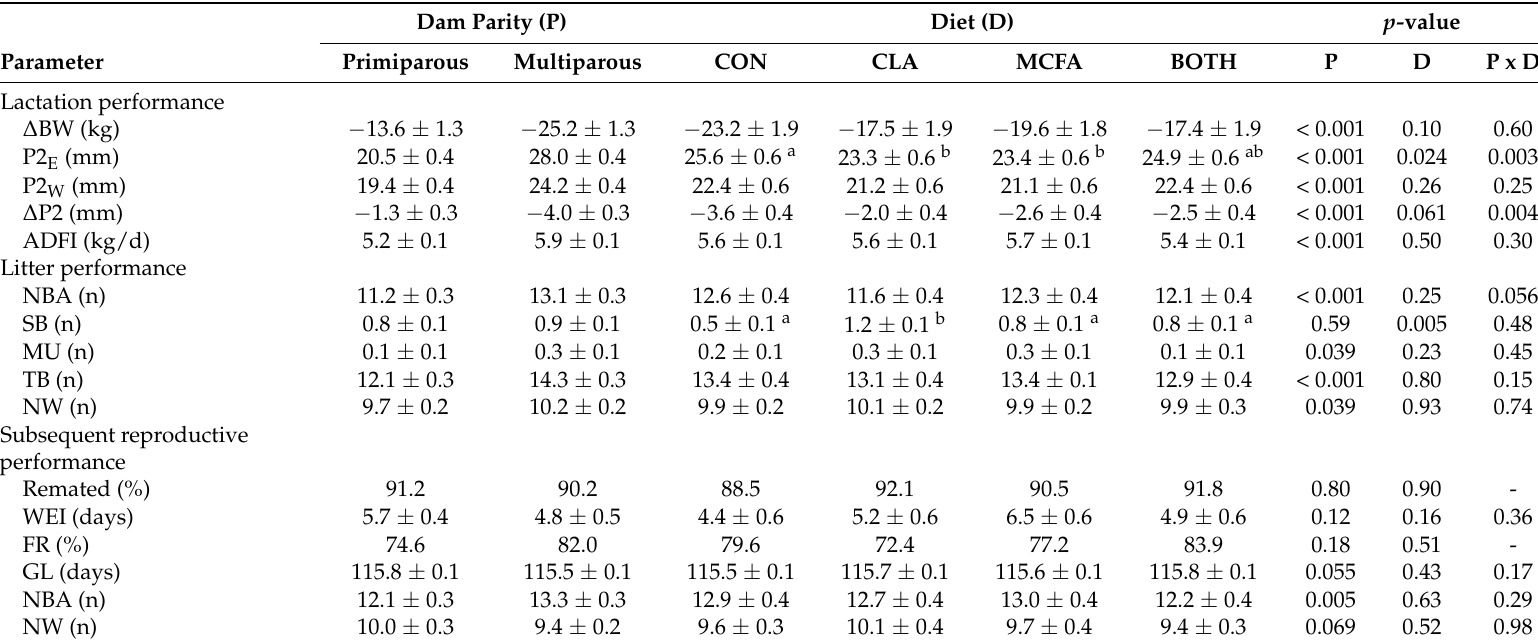
Table 4. Current and subsequent reproductive performance of primiparous and multiparous sows when fed either a commercial control diet (CON), a diet supplemented with conjugated linoleic acid (CLA), a medium-chain fatty acid (MCFA) product, or a combination of both CLA and MCFA (BOTH) in late gestation and